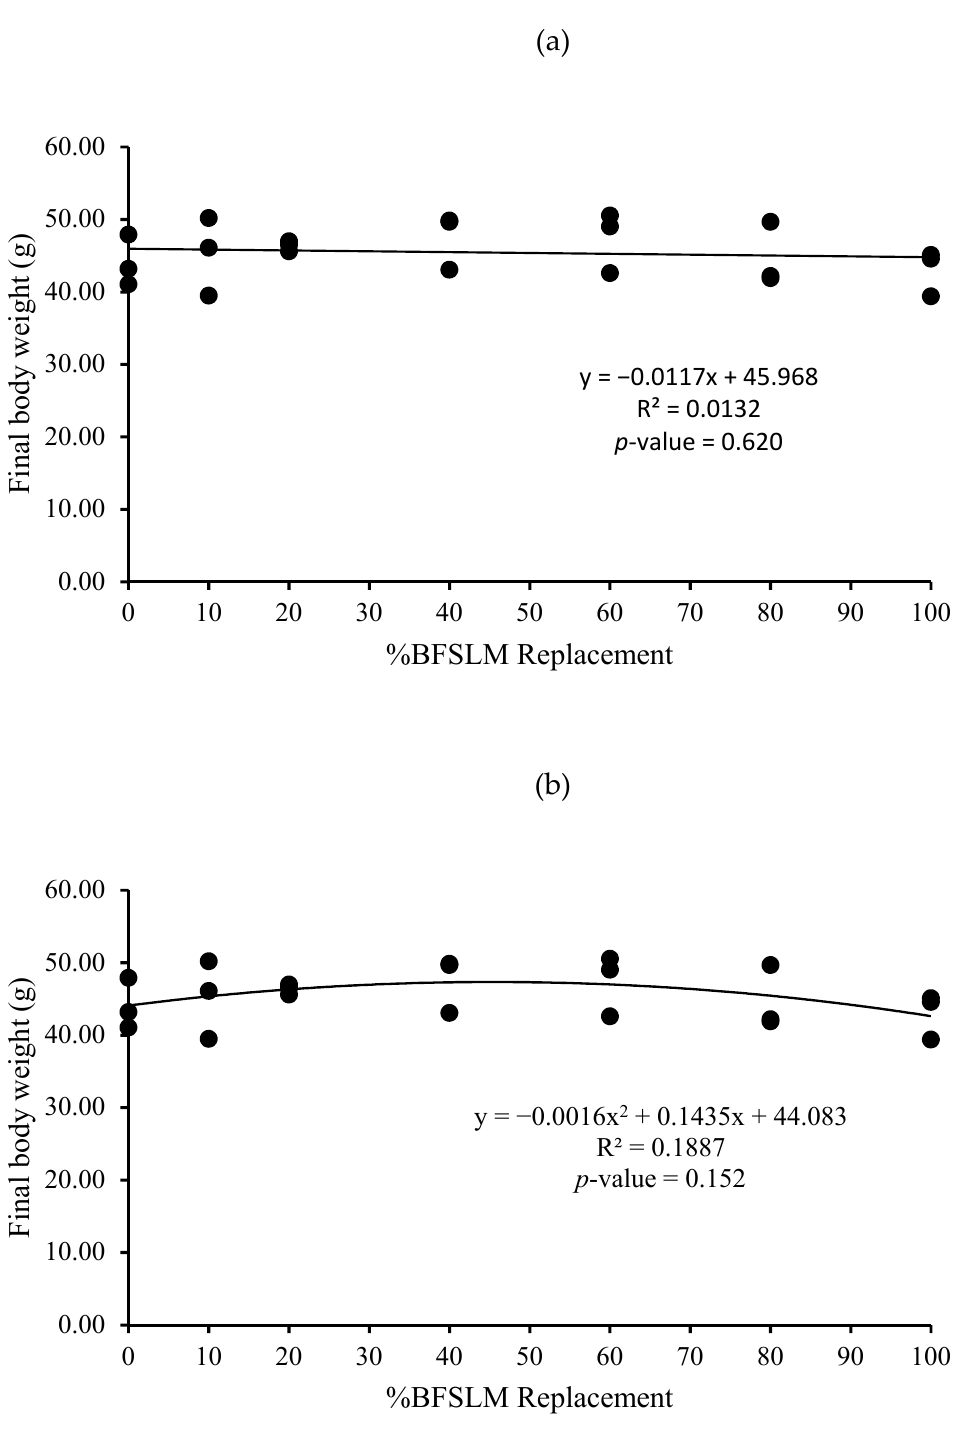
Figure 2. Linear ( a ) and quadratic ( b ) estimate: When X = %BSFLM replacement; Y = Final body weight after 12 weeks of feeding with control (0% BSFLM and 100% FM), and FM replaced at 10%, 20%, 40%, 60%, 80%, and 100% of the BSFLM.